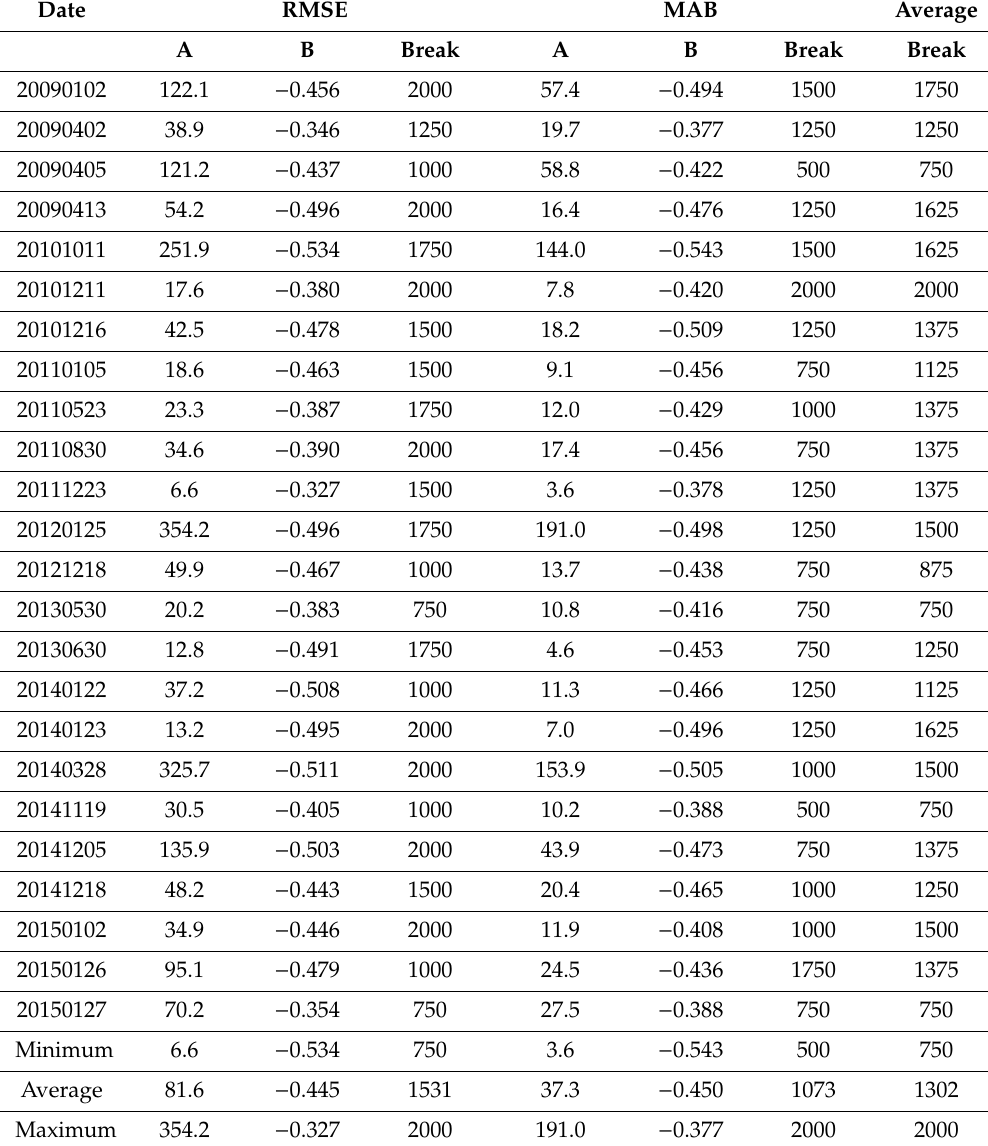
Table 2. Root-mean-square-error (RMSE) and mean absolute bias (MAB) scaling